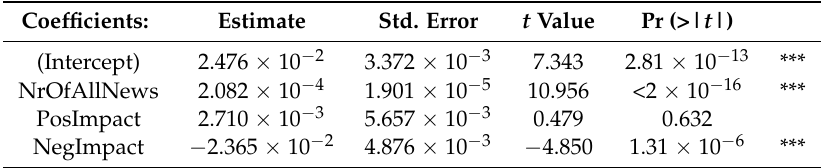
Regression analysis for volatility of the mean bond spread difference from Spain.